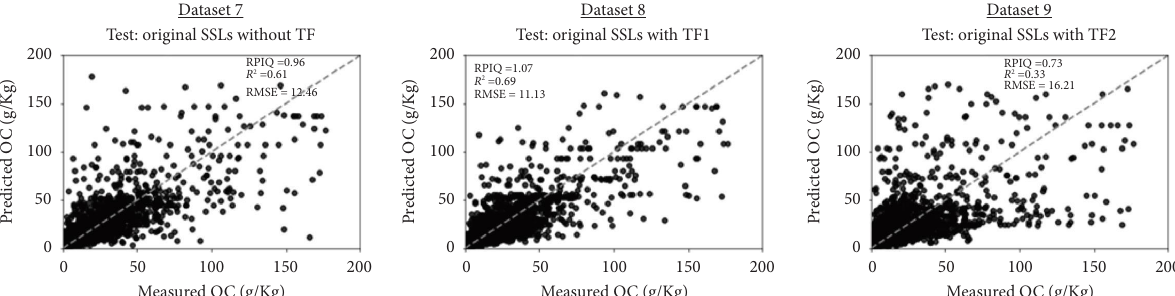
Figure 9: Te spectral-based models for OC content with their respective reference numbers (Table 1) using the original SSLs before and after TF (TFs1 and TFs2) execution.